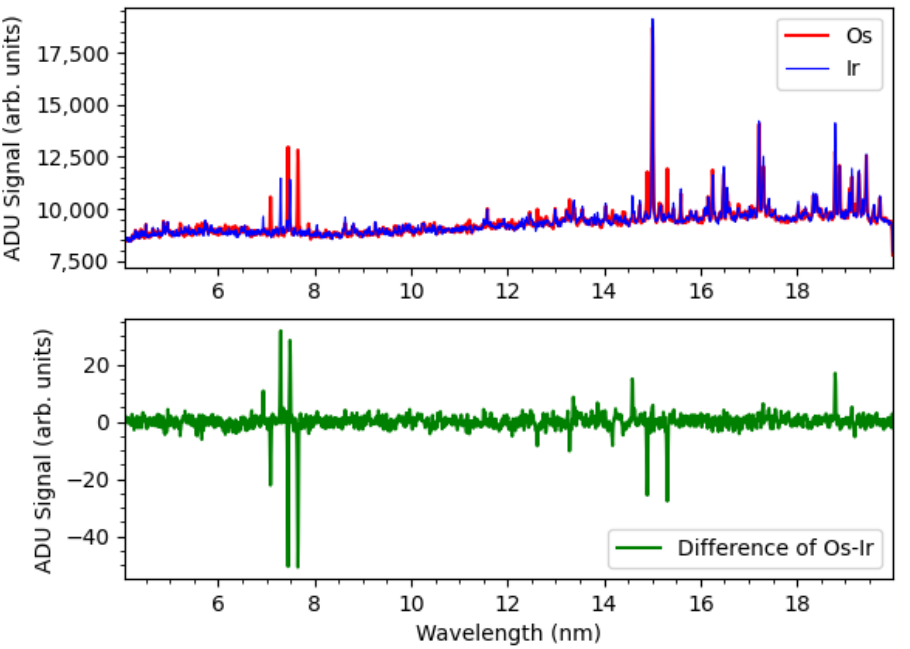
Figure 1. ( Top ) Spectra of highly charged Os and Ir in the EUV range at 18.1 keV electron beam energy and 150 mA electron beam current, exhibiting features from both elements and features that are present in both spectra. ( Bottom ) Subtraction method applied to above time-normalized